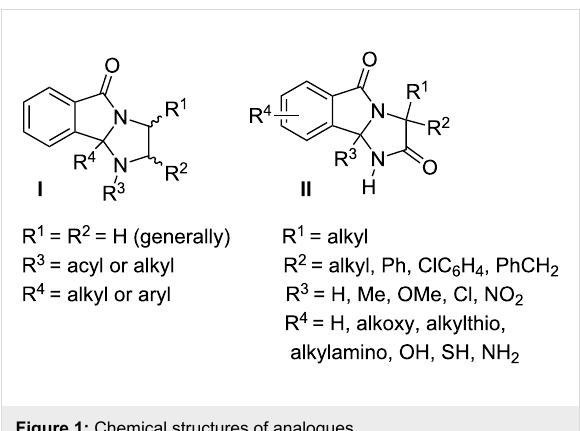
Figure 1: Chemical structures of analogues.